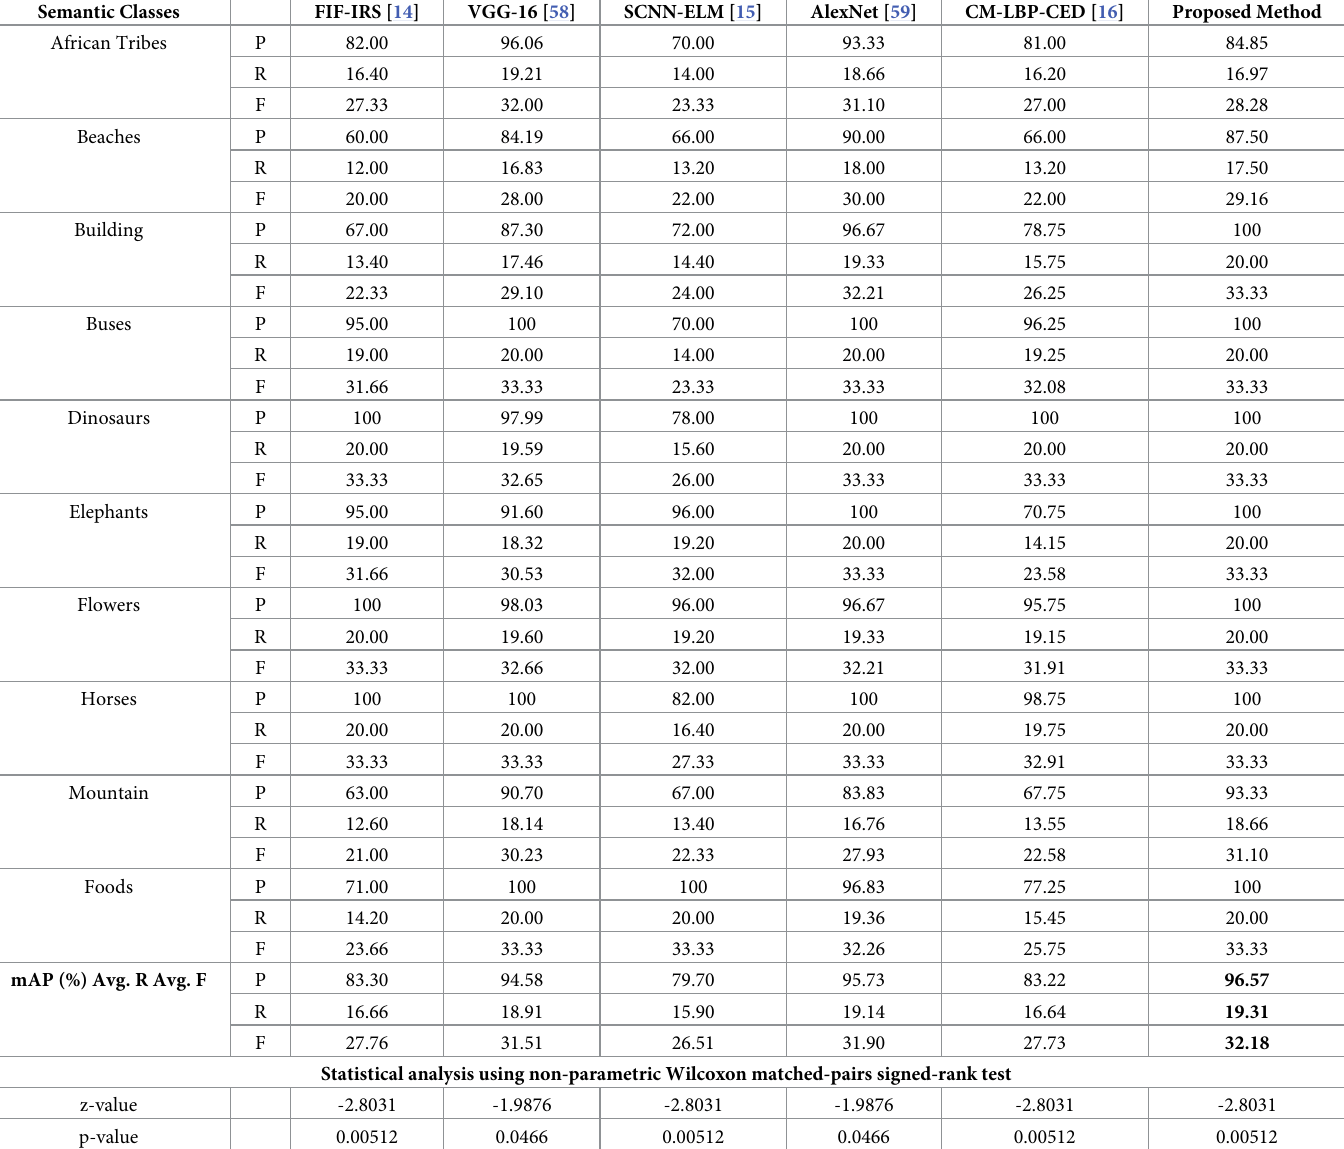
Table 2. Performance comparison of the proposed method with state-of-the-art methods on the Wang-A dataset (values presented in bold are significant among competitive methods). Semantic Classes FIF-IRS [14] African Tribes